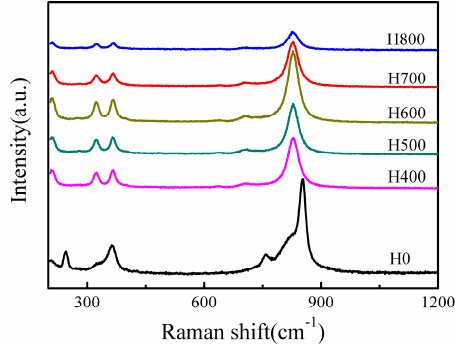
Figure 2. Raman spectra of the BiVO 4 samples synthesized under different conditions.